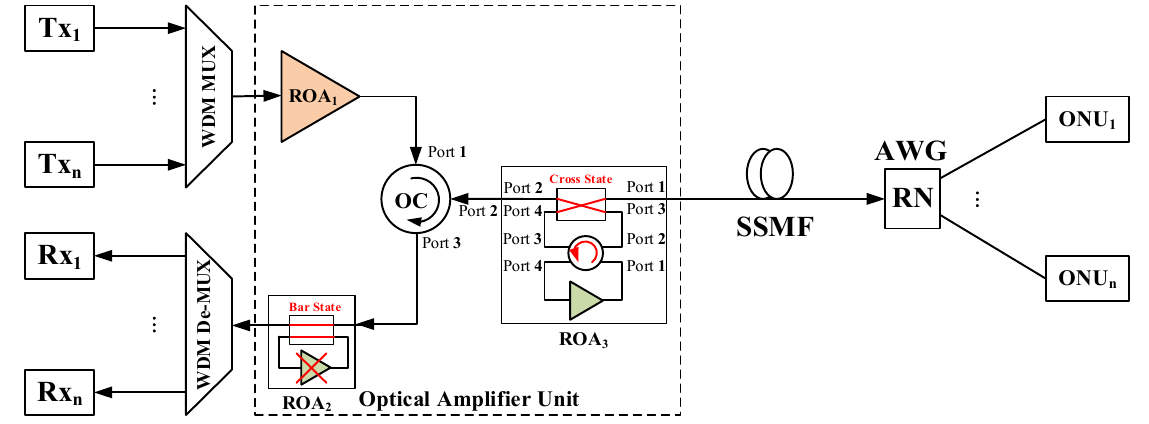
Figure 4. Protection state for ROA 2 .